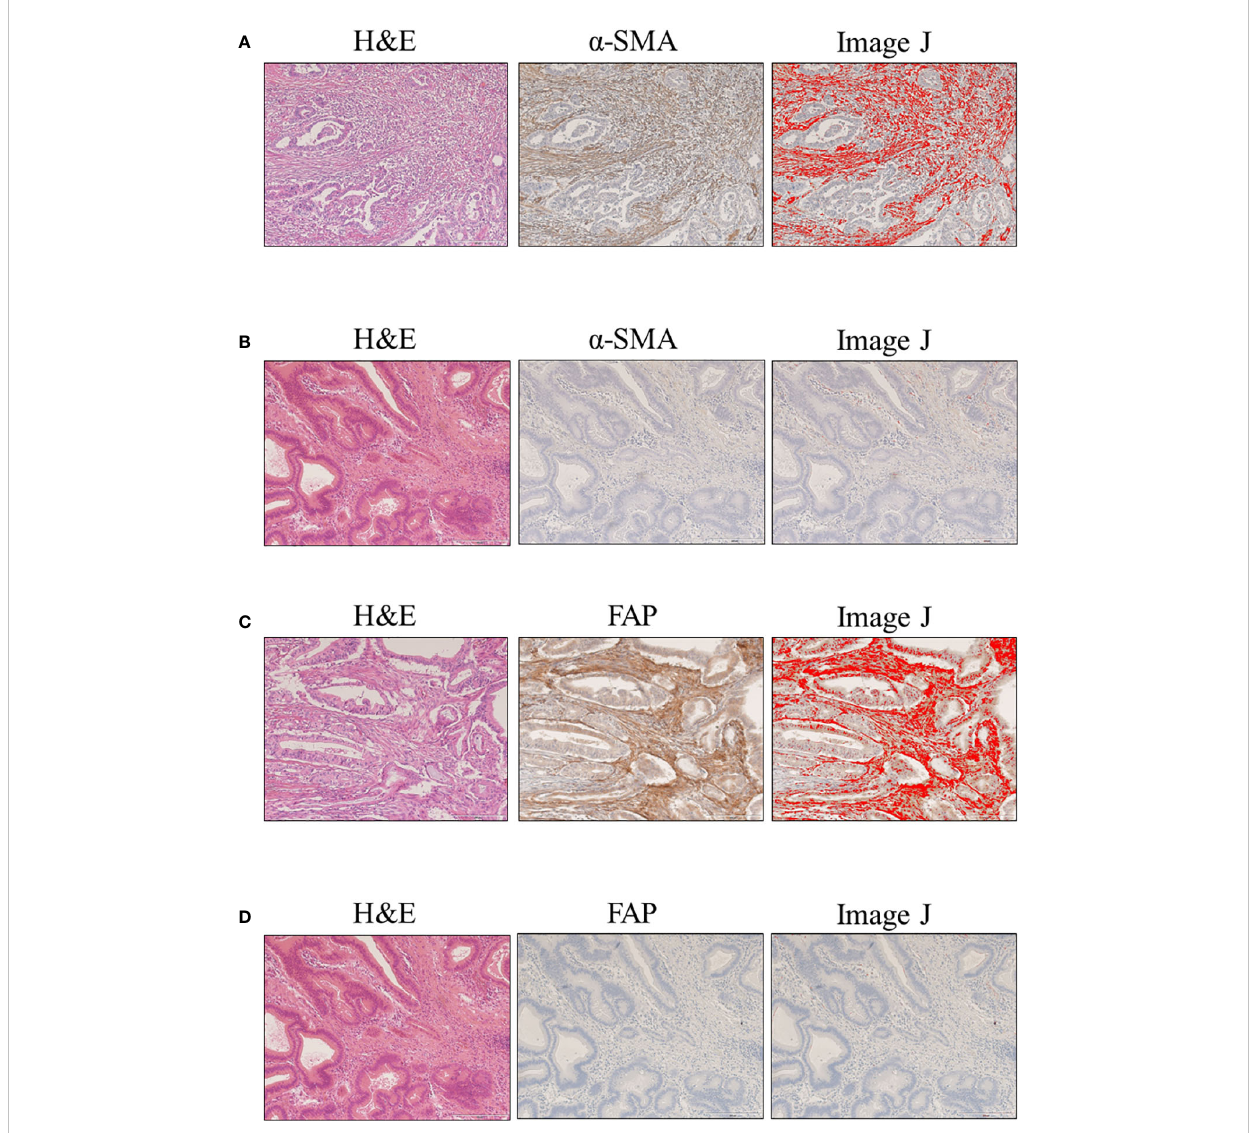
FIGURE 2 Evaluation of a -smooth muscle actin ( a -SMA) and fi broblast activation protein (FAP) expression in clinical samples of ampullary carcinoma. Microscopic images with hematoxylin and eosin (H&E), cancer-associated fi broblasts (CAF) staining, and Image J: (A) high a -SMA expression; (B) low a -SMA expression; (C) high FAP expression; and (D) low FAP